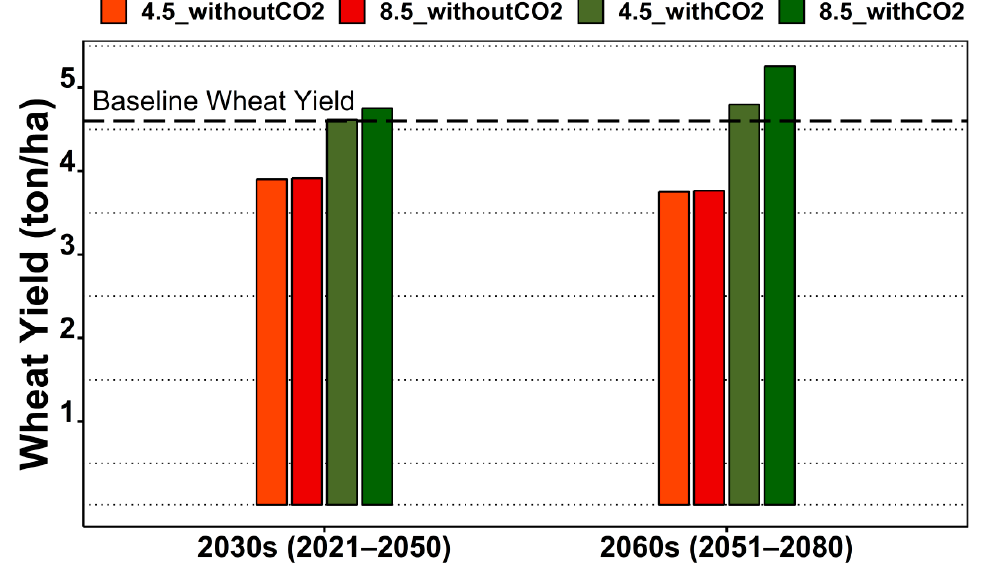
Figure 9. Projected wheat yield under future climate change during the two time slices.